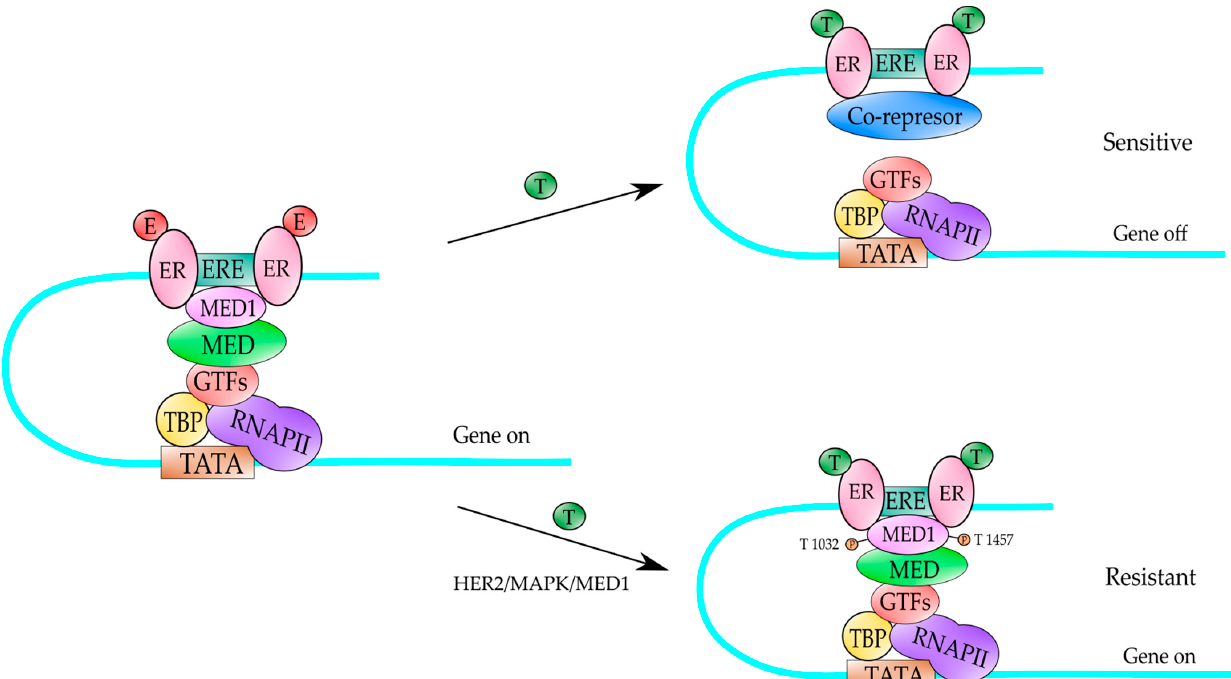
Figure 2. A mechanism to explain the tamoxifen-resistance in ER-positive HER2-expressing BC. Under normal cellular conditions, the estrogens (E) can bind to the ER and activate gene expression of ER-target genes (gene on). In those ER-positive BC, the tamoxifen (T) binds to the ER and produces a conformational change that results in the recruitment of transcriptional co-repressors (SMRT and N-CoR) which block gene expression (gene off) of ER-target genes, and it produces a tamoxifen-sensitive BC. However, in the presence of HER2 receptor, the ER receptor bound to tamoxifen (T), recruits MED1 co-activator, which is heavily phosphorylated by MAPK kinases (activated by HER2) producing an activation of those ER-target genes (gene on) and the BC becomes tamoxifen-resistant. MAPK kinases phosphorylate MED1 at T residues in position 1032 and 1457. TATA is the DNA-binding sequence of TBP factor in the gene promoter. RNAPII is the RNA polymerase II enzyme which transcribes. MED is the Mediator complex. GTFs are the auxiliary factors for RNAPII and ERE is the estrogen response element.